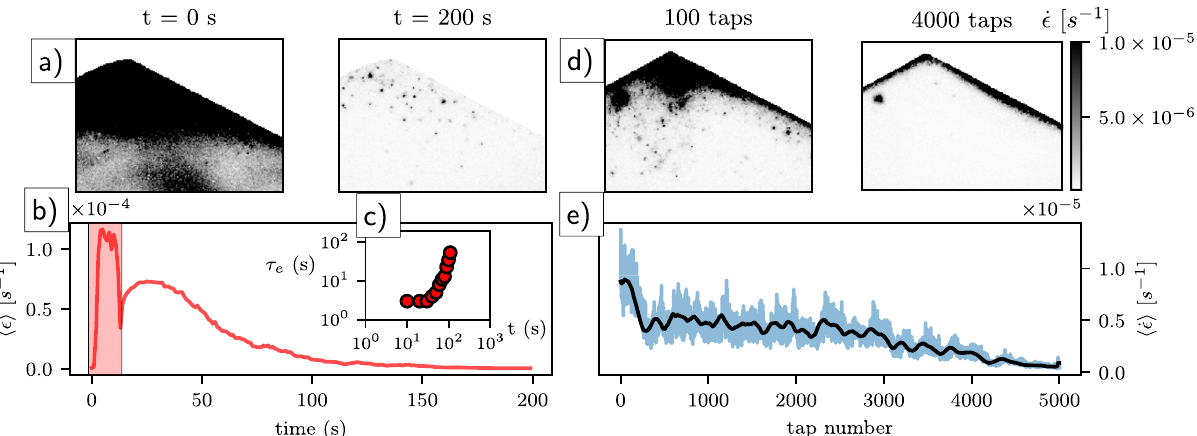
Fig. 4 Mechanical perturbations drive rejuvenation or aging. a Spatial maps of strain rate during and following heat pulse, with time indicated. b Spatially- averaged strain rate, including 10 s of heating applied (red rectangle), and relaxation after removal of the heat source. c Relaxation timescale τ e during and following heat response (Supplementary Fig. 10). d Spatial maps of strain rate determined over one tap cycle (tap number indicated in fi gure). Note that after many taps, creep is mostly con fi ned to a thin, localized layer at the surface. e Time series of spatially-averaged strain rate (blue line) during tapping (1 tap = 1 s). Black line indicates moving-window average (100